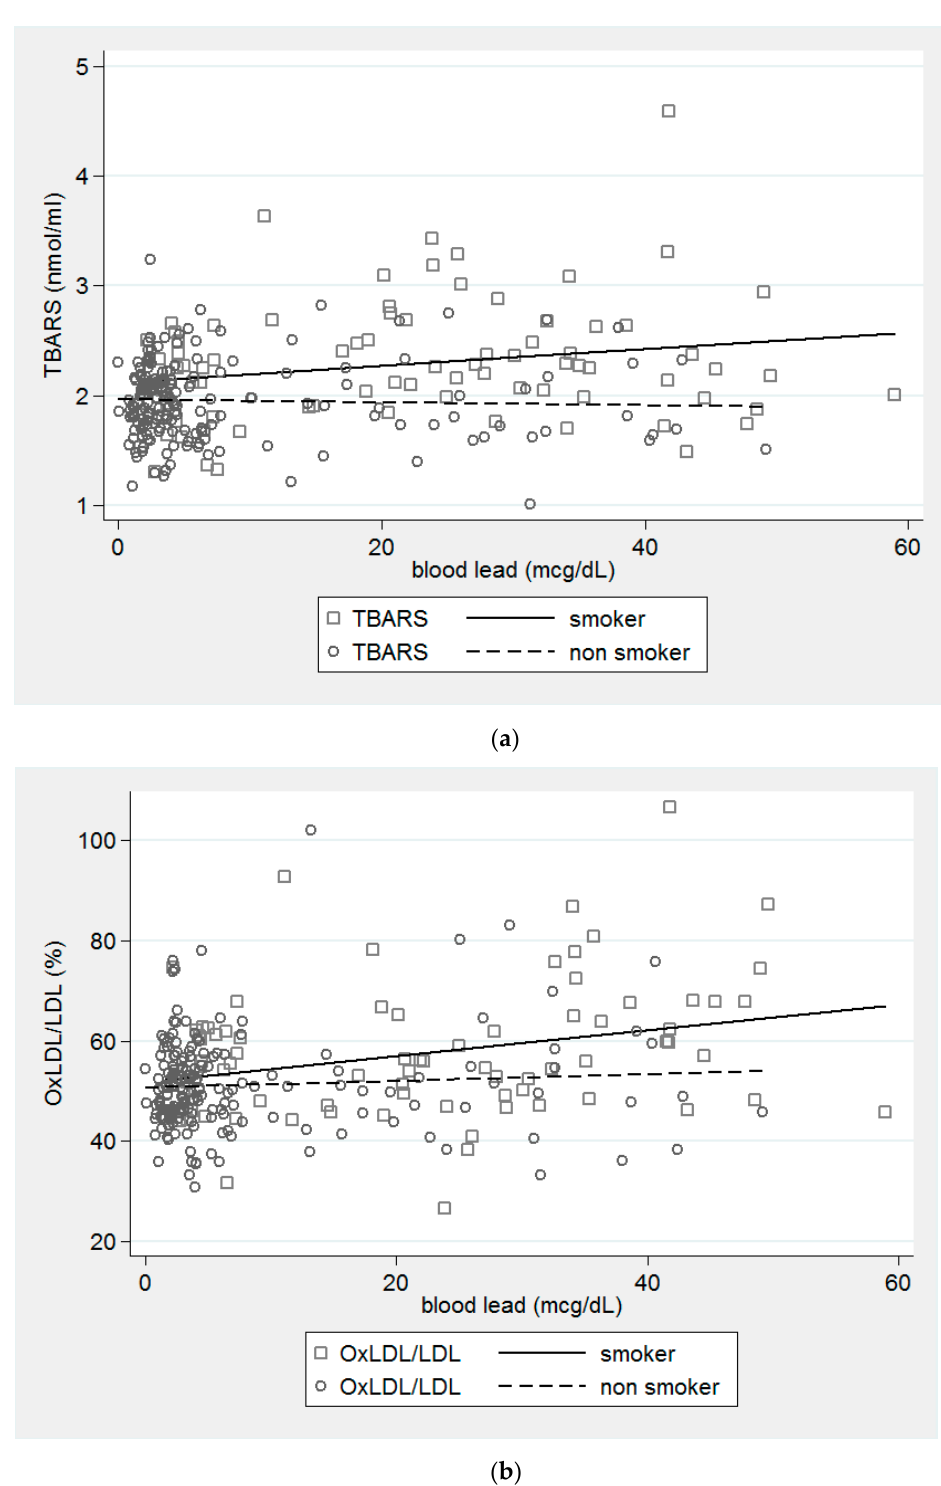
Figure 1. The interaction effect of smoking on the levels of TBARS and ratio of OxLDL/LDL in Pb-exposed workers. ( a ) The difference between the levels of TBARS was greater for smokers than nonsmokers in Pb-exposed workers. ( p = 0.041). ( b ) The difference between the ratio of OxLDL/LDL was greater for smokers than for nonsmokers. ( p = 0.044).